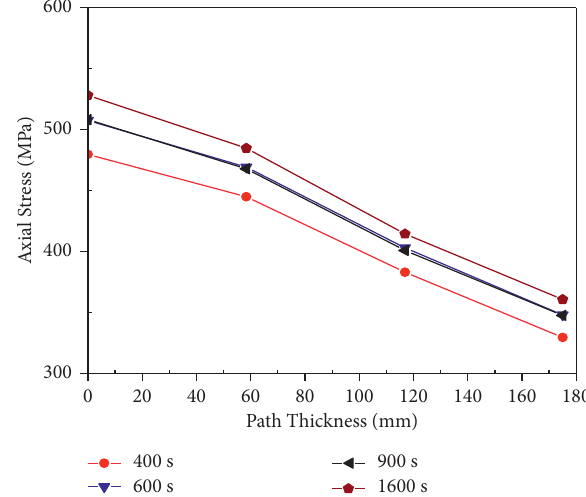
Figure 12: Temperature distribution through the inlet nozzle-inner RPV wall intersection (path) thickness at different times.